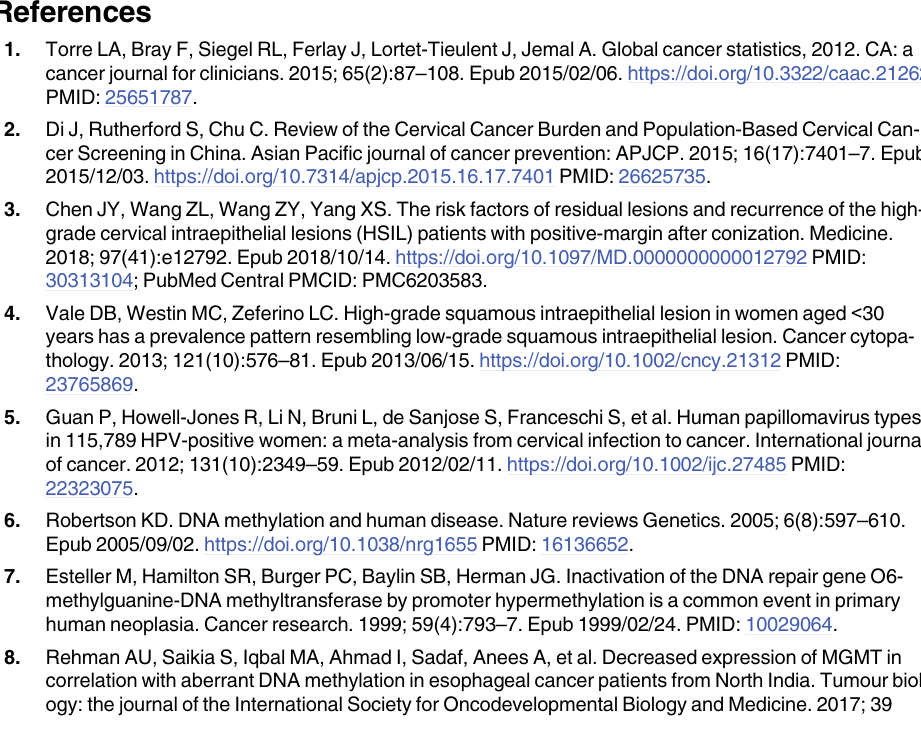
S1 Table. Original minimal datasets in this